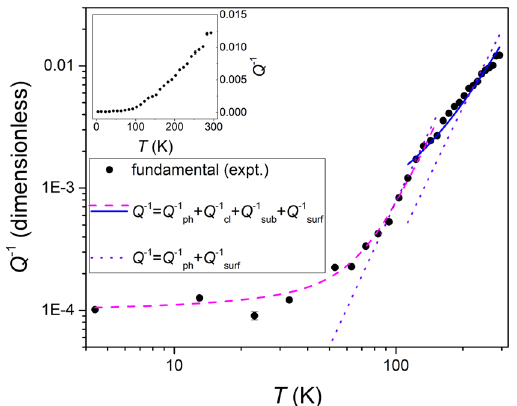
Figure 4. Temperature dependence of the energy dissipation. Inverse quality factor (energy dissipation), Q − 1 , as a function of temperature, T . The solid black circles are the experimental data determined from measurements of the fundamental mode temperature dependence. The solid blue and dashed magenta lines are fits to the experimental data for T > 110 K and T < 110 K, respectively, which take into account four dissipation pathways: Q − 1 ph = phonon-phonon dissipation, Q − 1 cl = clamping dissipation, Q − 1 sub = dissipation from electrostatic interactions with the substrate, and Q − 1 surf = surface dissipation. The dotted violet lines are fits to the data within the high and low temperature ranges that only take into account Q − 1 ph and Q − 1 surf . Inset: Q − 1 versus T on a linear scale. The y -axis units are